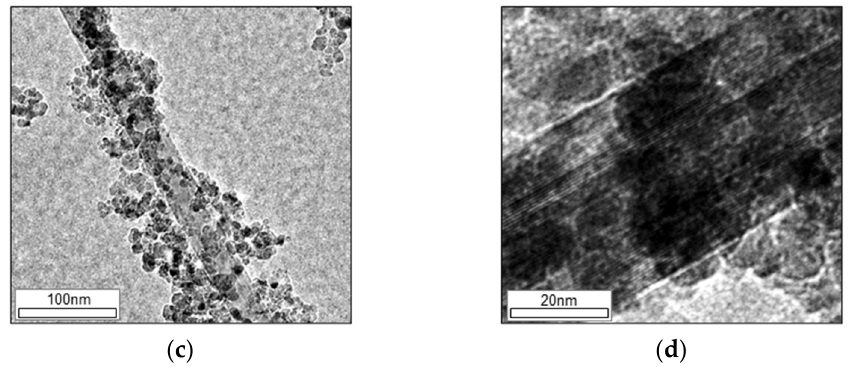
Figure 2. TEM images of ( a ) α -MnO 2 ; ( b ) Fe 3 O 4 MNPs; ( c ) Fe 3 O 4 / α -MnO 2 ; ( d ) HRTEM image of Fe 3 O 4 / α -MnO 2 .